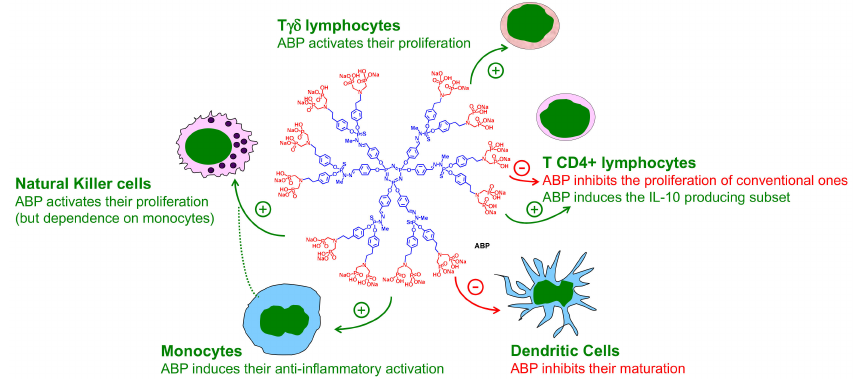
Figure 6. Overview of the different immuno-modulatory effects displayed by the ABP dendrimer towards different sub-populations of human mononuclear immune cells of the peripheral blood: T γδ lymphocytes [32], T CD4+ lymphocytes [22,35], Dendritic Cells [36], Monocytes [22], Natural Killer cells